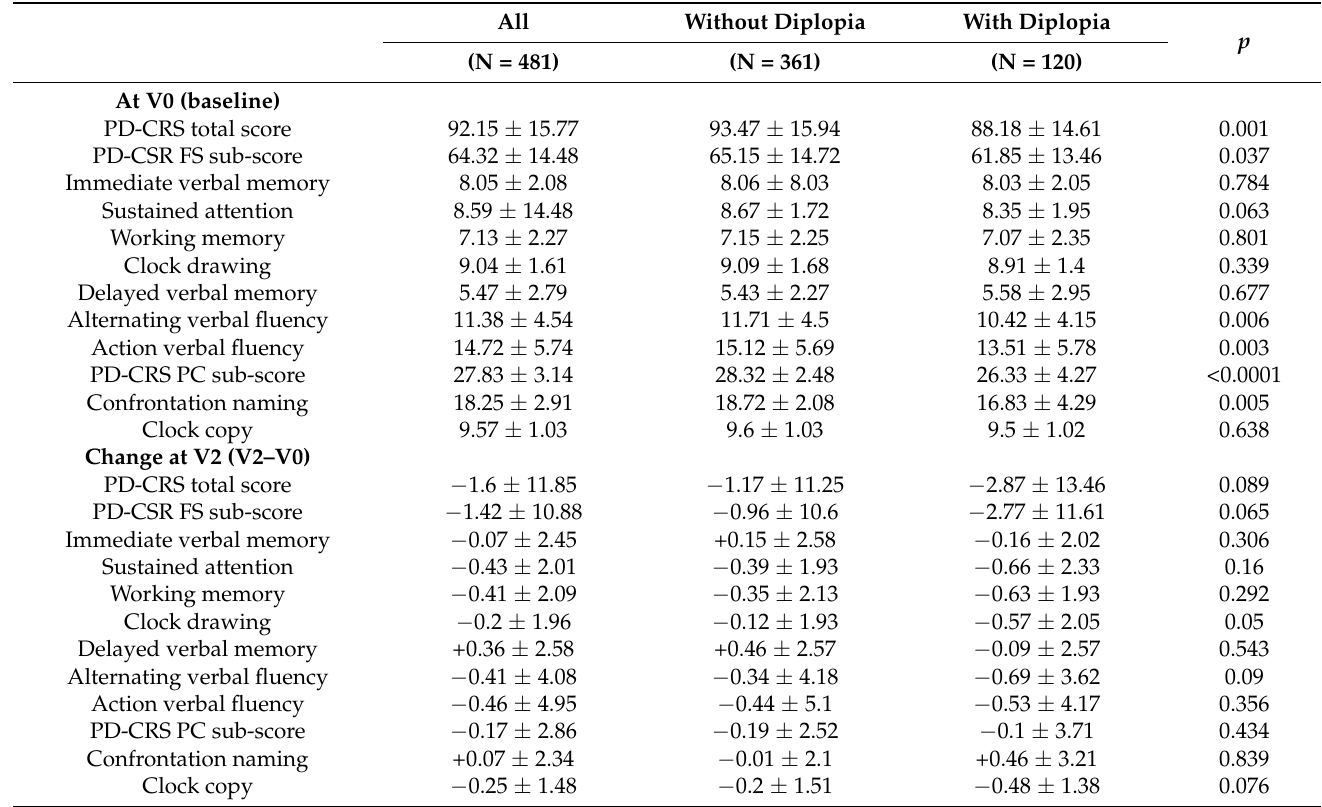
Table 2. Cognitive function in patients with diplopia compared to those ones without diplopia (N = 481).